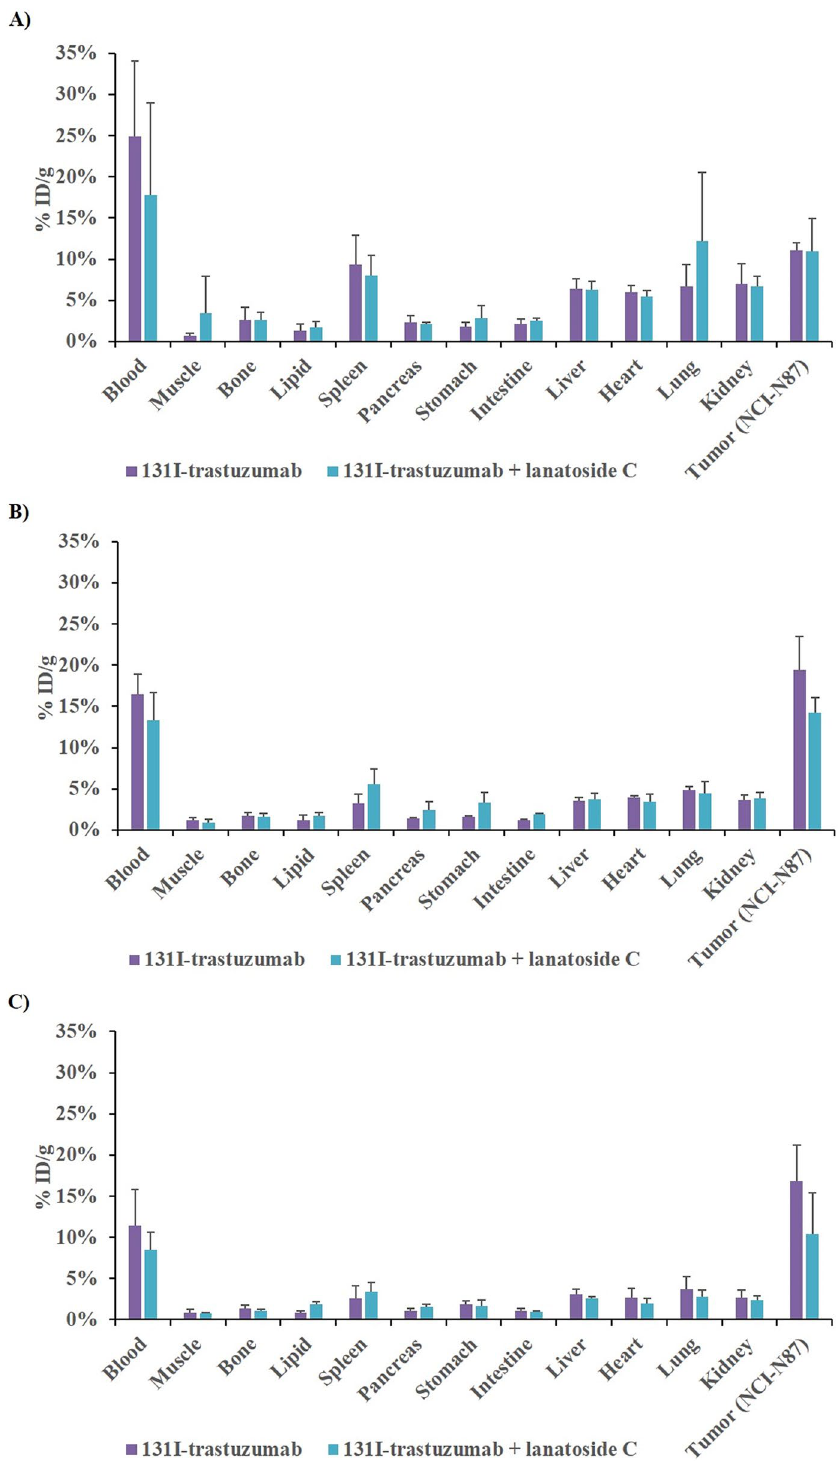
Figure 4. Biodistribution pattern (% ID/g) of 131 I-trastuzumab or combination of 131 I-trastuzumab and lanatoside C in tumor (tumor xenograft NCI-N87) bearing BALB/c nude mice at 4 h ( A ), 24 h ( B ), and 48 h ( C